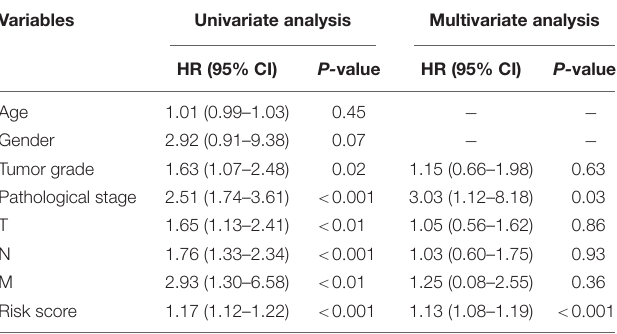
TABLE 4 | Univariate and multivariate Cox regression analysis for clinical